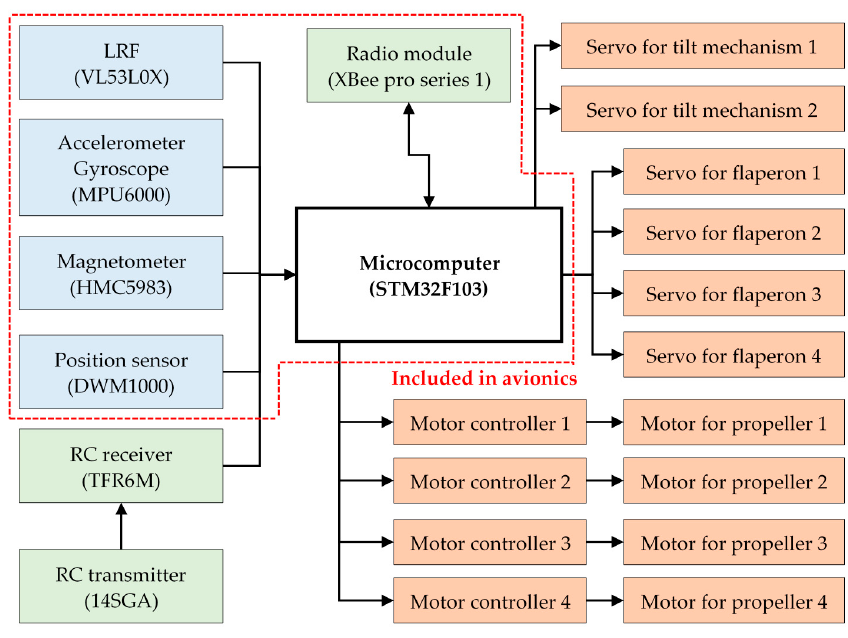
Figure 16. System diagram.